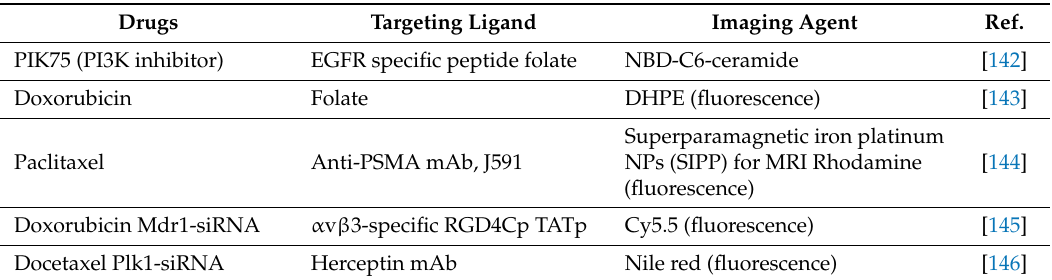
Table 7. Multifunctional NEs for cancer diagnostic and therapy.